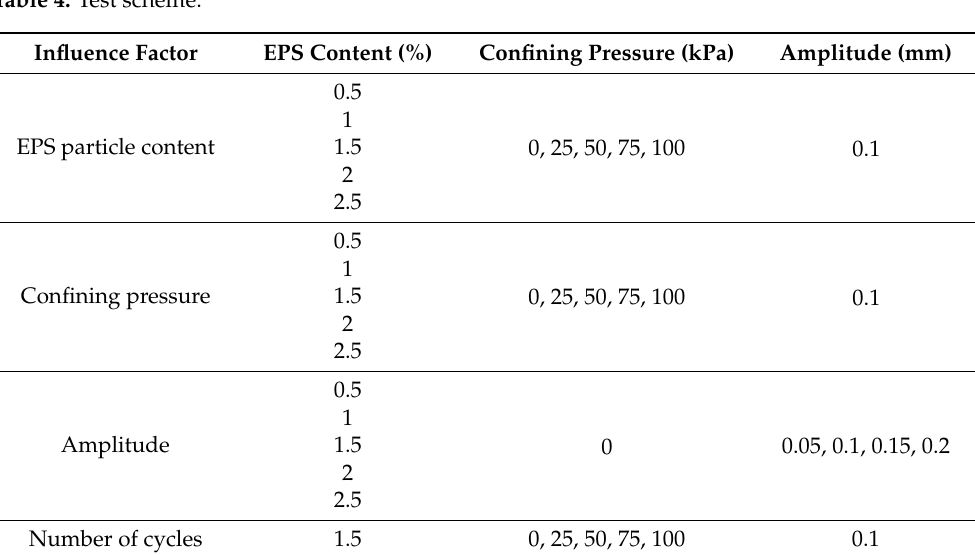
Figure 3. Uncon fi ned compression test and microscopic test diagram of SLS. Figure 3. Unconfined compression test and microscopic test diagram of SLS. Table 4. Test scheme. Table 4. Test